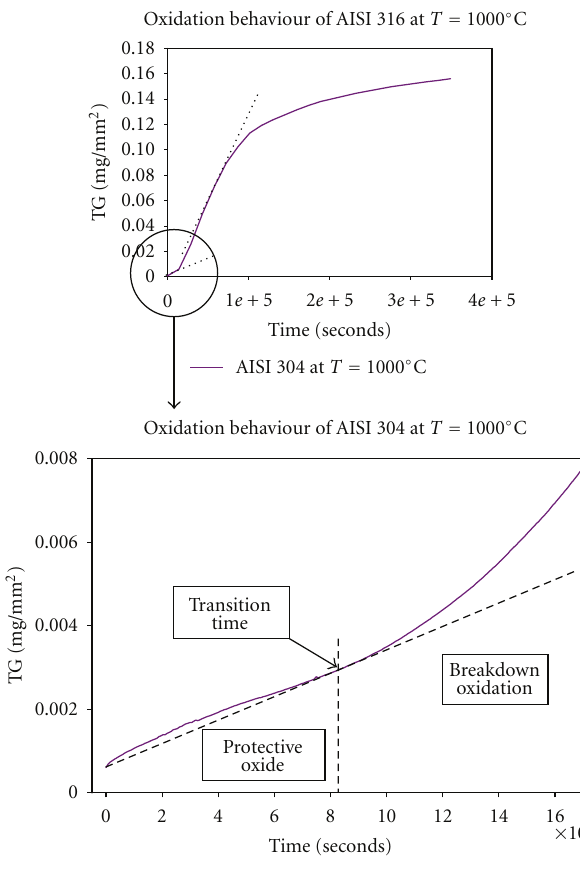
Figure 1: The scale breakdown obtained of AISI 304 at T = 1000 ◦ C in synthetic